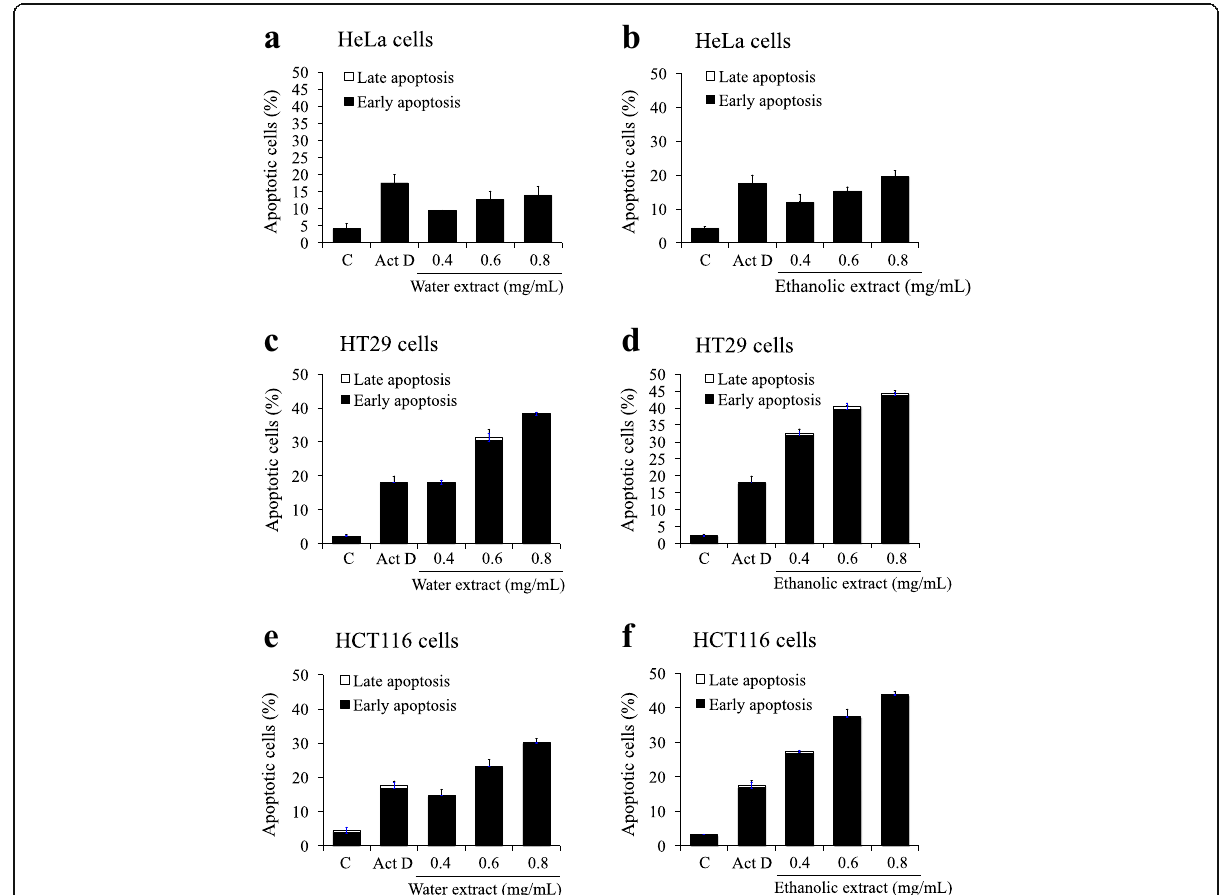
Fig. 3 Flow cytometric analysis of apoptosis induction in HeLa ( a , b ), HT29 ( c , d ) and HCT116 ( e , f ) cells. Cells were treated with various concentrations of water and ethanolic extracts prepared from the powdered formula of H. cordata fermented broth and P. emblica fruit for 24 h. The Annexin V-FITC/PI staining apoptotic cells were analyzed using flow cytometry. Actinomycin D (Act D; 10 μ g/mL) was used as a positive control. Bar graph shows the summarized data from three independent experiments performed in duplicate compared with untreated control ( c